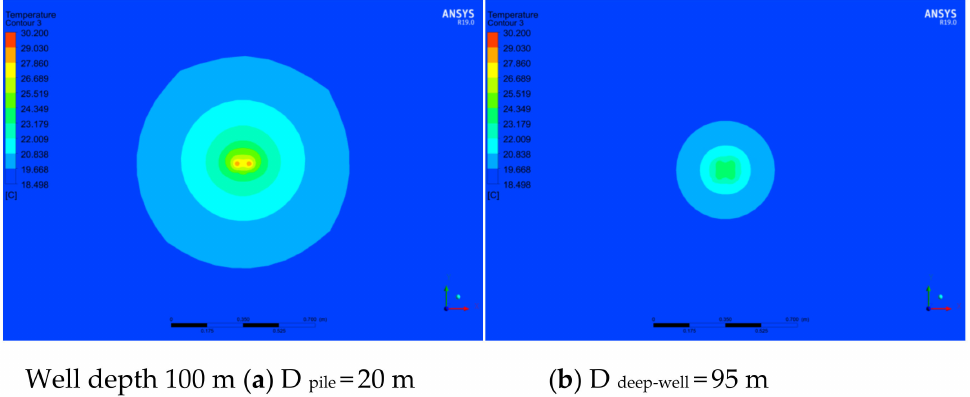
Figure 15. Cloud diagram of temperature distribution at pile bottom and deep well bottom when #2 pile well is 100 m